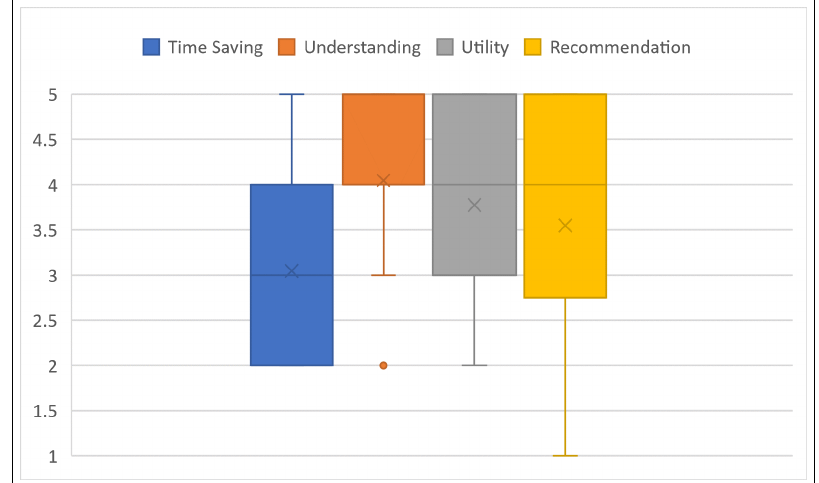
Figure 3. Expected influence of VIPER on increased understanding and time saving assessed by the participants and estimation of the potential of VIPER in terms of usefulness and recommendation potential when applied as a patient education tool. Likert scale from 1 to 5 (1: does not apply at all; 5: fully